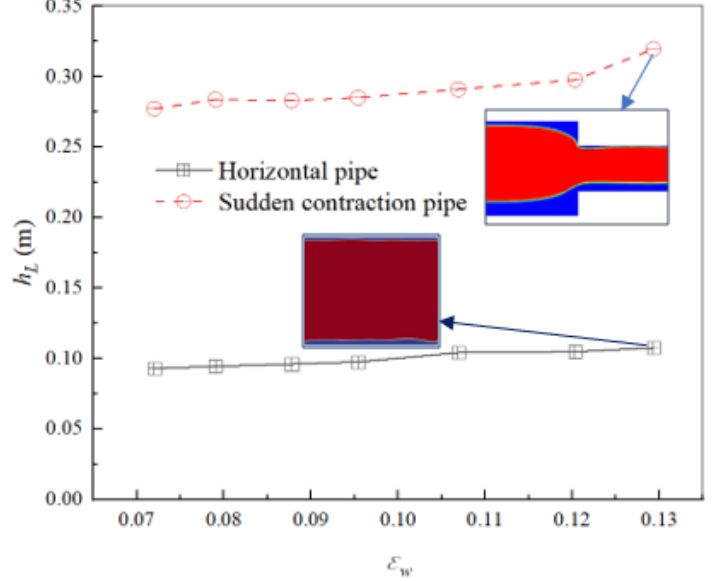
Figure 5. The effect of water cut on head loss.